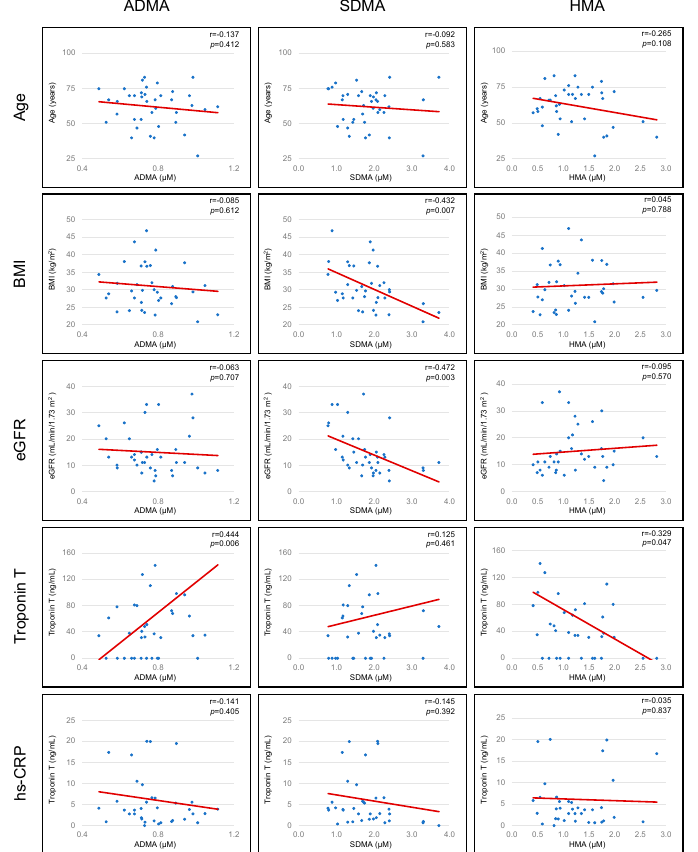
Figure 3. Association between arginine metabolites and patient baseline characteristics: Age, BMI, eGFR, troponin T and hs-CRP.